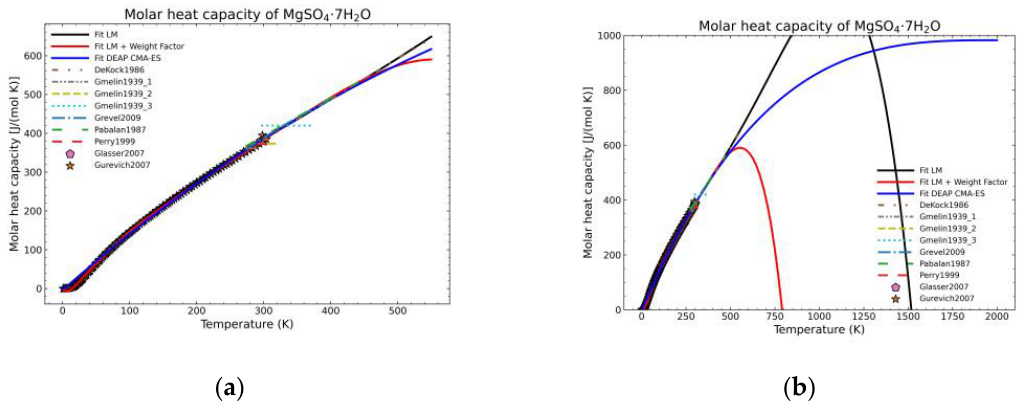
Figure 11. Comparison of the different fit results of MgSO 4 ·7H 2 O showing: ( a ) literature points region; ( b ) extended range until 2000 K.